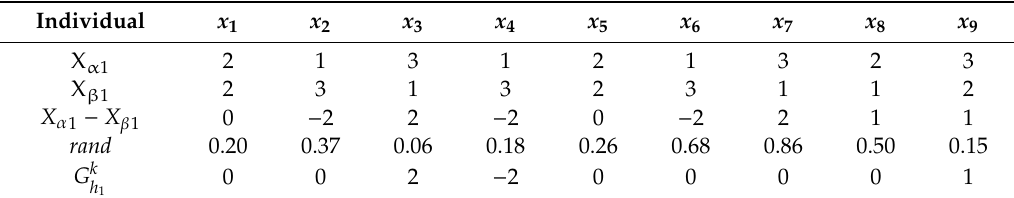
Table 4. Generation of temporary vector G k